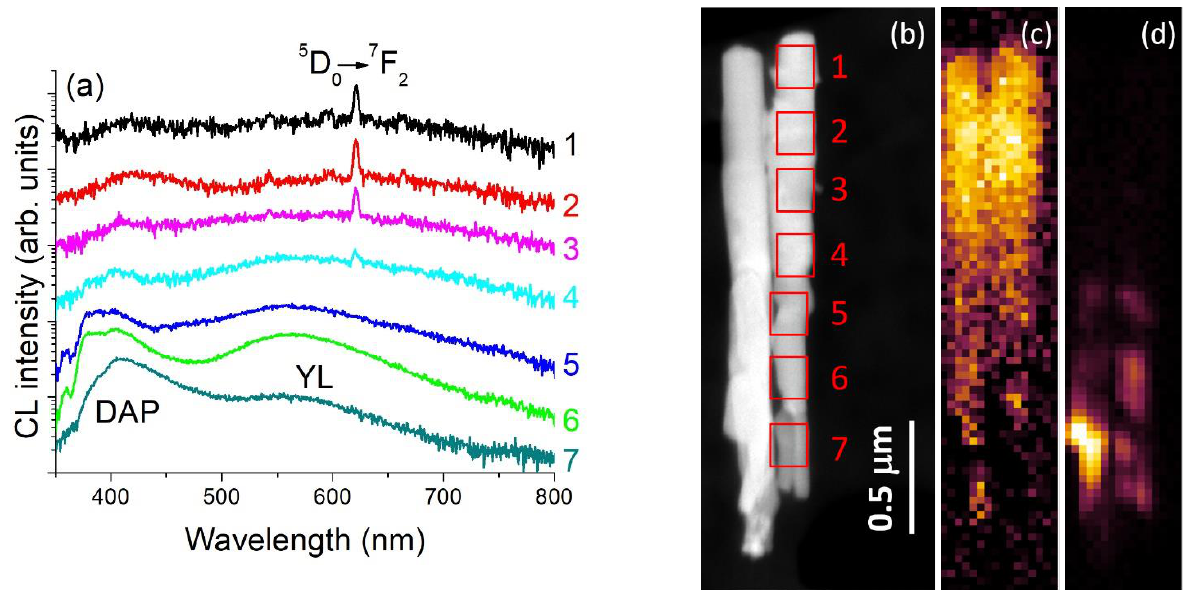
Figure 8. ( a ) Nano-cathodoluminescence (CL) spectra taken at seven points from the top (1) to the bottom (7) of a single NW implanted using a fluence of 1 × 10 14 at/cm 2 (20° incidence angle) and annealed at 1000 °C. The regions where the spectra were taken are indicated with red rectangles in ( b ). ‘’DAP’’ denotes donor –acceptor pairs and ‘’YL’’ stays for yellow luminescence. ( c , d ) Luminescence intensity maps integrating the spectra in a wavelength region around the 622 nm Eu 3+ line ( c ) and from 350 to 550 nm ( d ). Adapted with permission from Ref. [45].